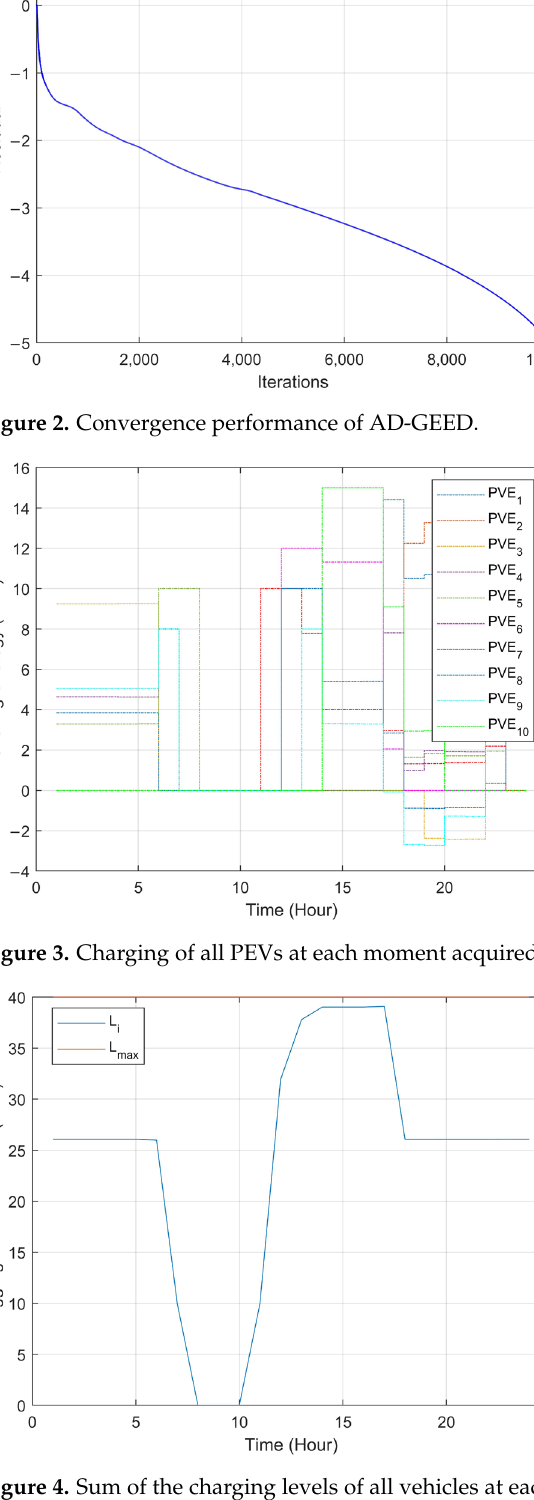
Figure 4. Sum of the charging levels of all vehicles at each moment acquired by AD-GEED.